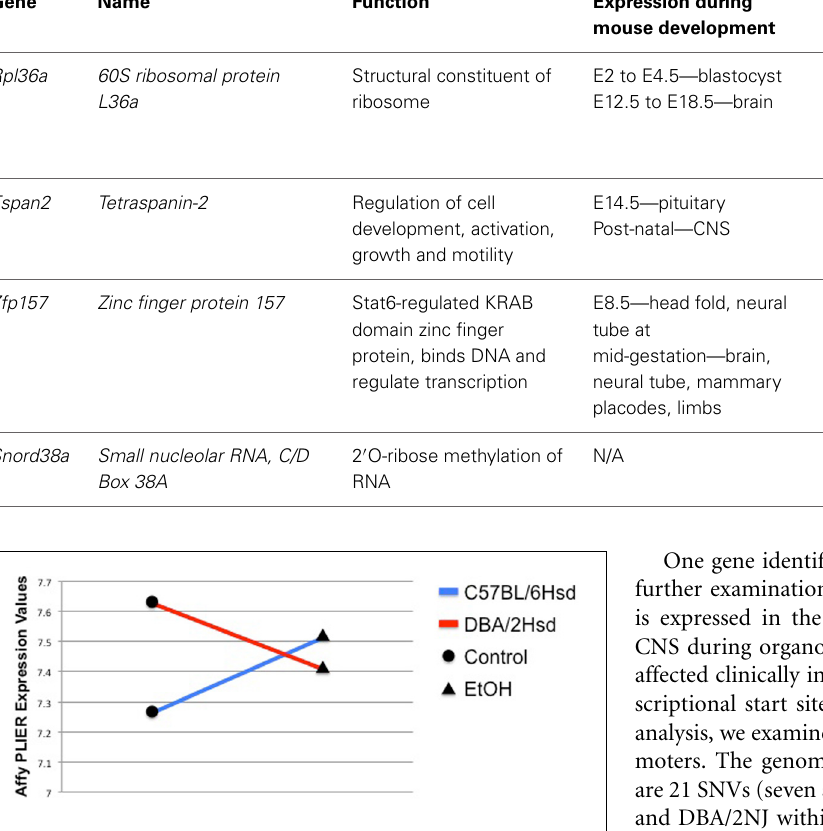
FIGURE 2 | Eya2 demonstrates a strong GxE interaction. The Affymetrix PLIER expression levels are shown on the Y-axis. The black circles represent gene expression levels in control embryos, while the triangles represent gene expression levels in the alcohol-treated animals. Two conditions are measured in this experiment, gene expression levels in controls and gene expression levels in EtOH-treated animals. The blue line depicts the changes in gene expression found between the C57BL/6NHsd control embryos (black circle) and their EtOH-treated test embryos (black triangle). The red line depicts the changes in in gene expression found between the DBA/2NHsd control embryos (black circle) and their EtOH-treated test embryos (black triangle). The interaction is depicted by showing an inverse correlation between the gene expression profiles of the two inbred